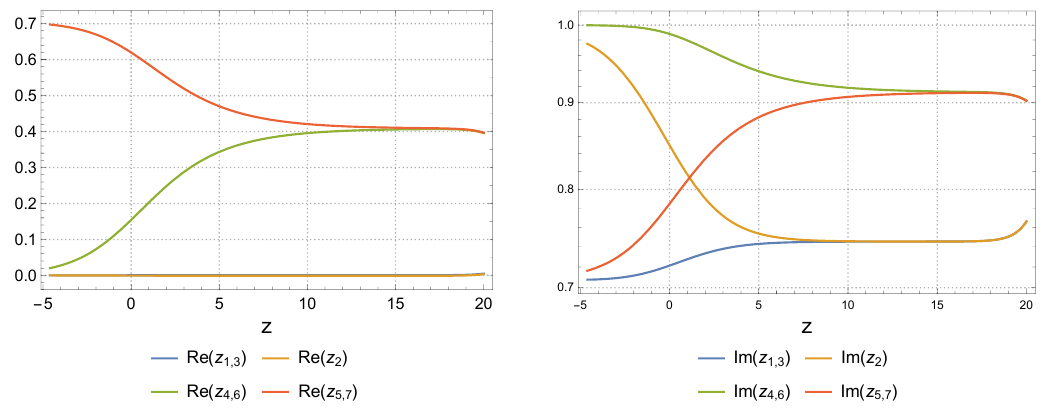
Figure 10 . Holographic RG flow from N = 1 & SU (3) J-fold CFT 3 (UV, right) to N = 2 & SU (2) J-fold CFT (IR, left) with (Λ 3 0 . 3421361222)